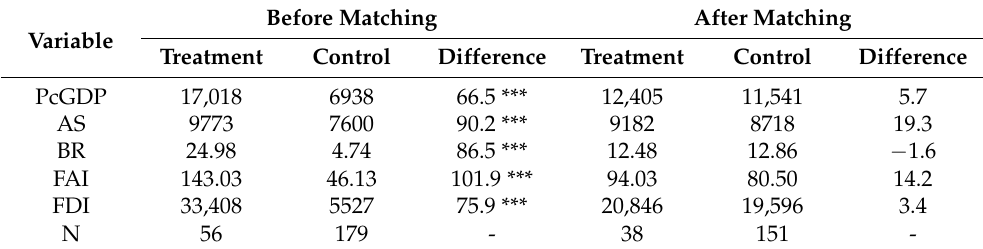
Table 3. Results of the balance